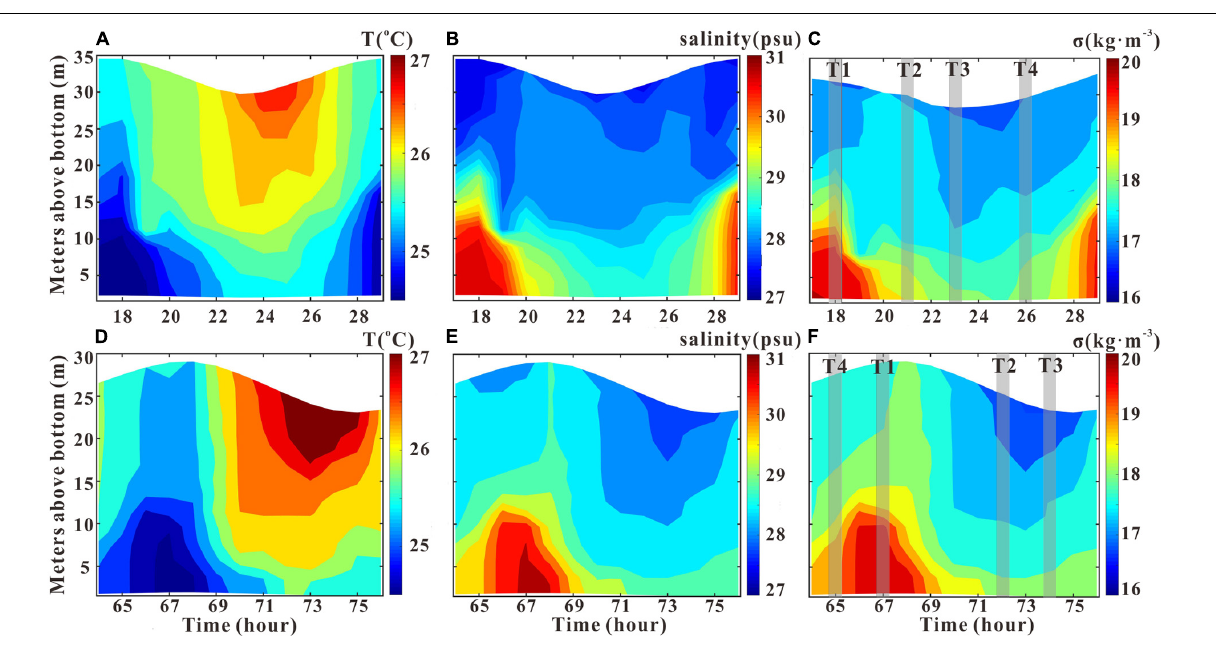
the lower (0.15–0.25 h) ( u b , v b ) water column have